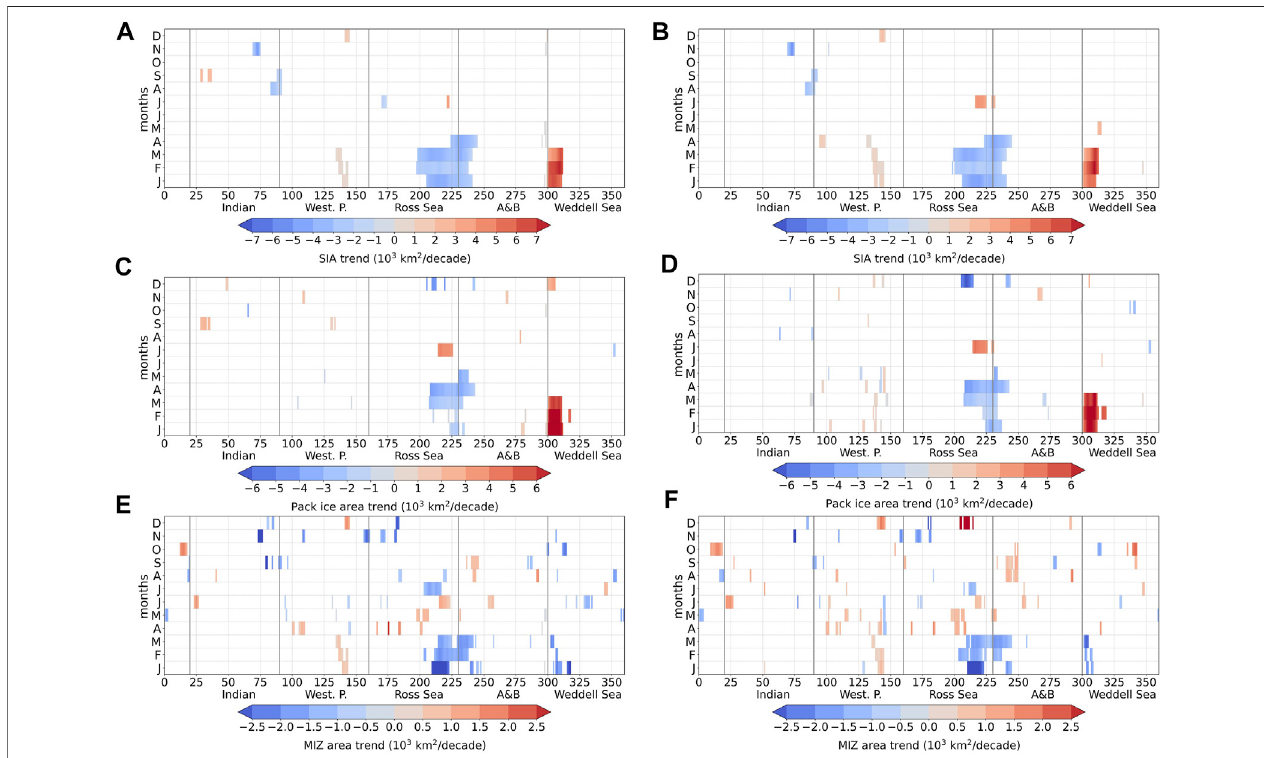
FIGURE8| Monthlytrends(1993 – 2019)inregionalareasoftotalice (A,B) ,packice (C,D) ,andMIZ (E,F) ,asafunctionoflongitude.Left(right)columnscorrespond to GREP (CDR). Only signi fi cance higher than 95% are shown. Note that colorbar scales are different for ice